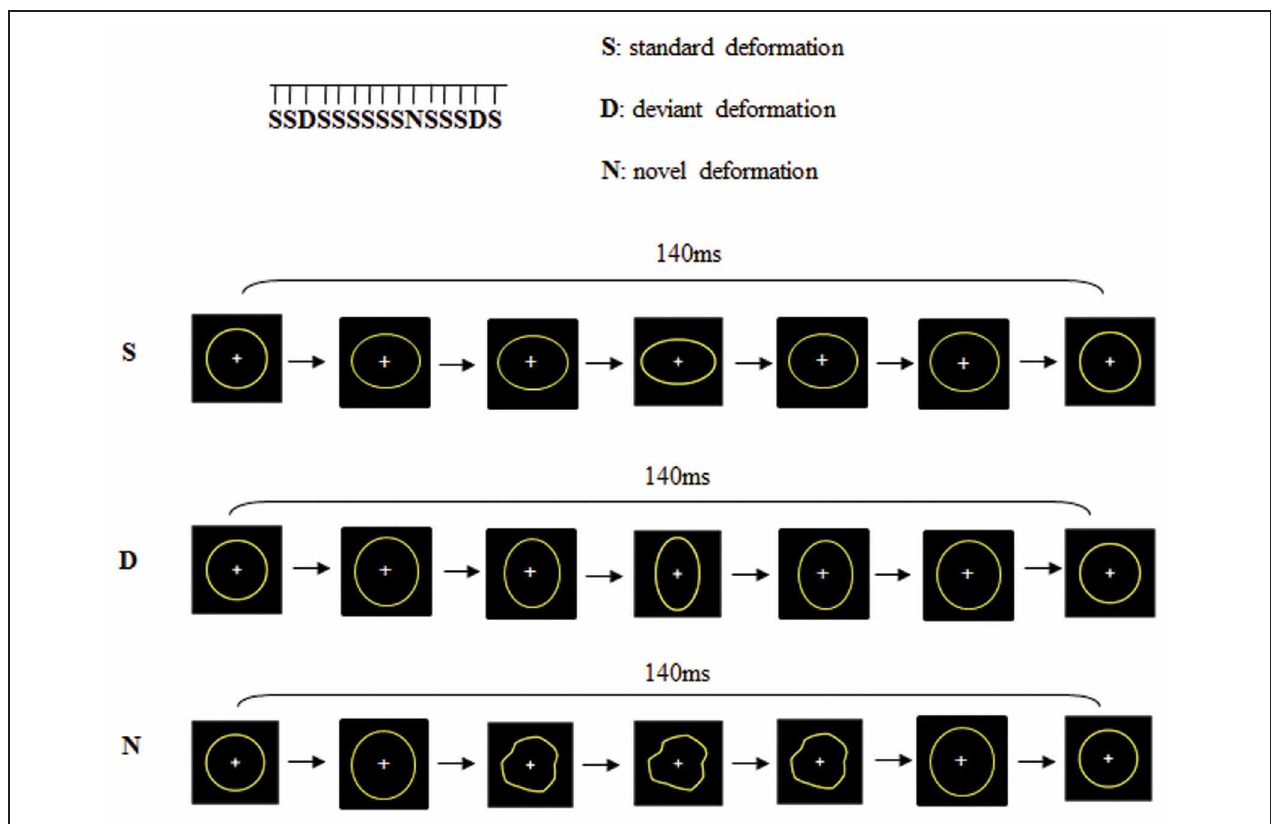
FIGURE 1 | Dynamic stimuli consisted on the deformation of a circle into an ellipse either horizontally (standard deformation) or vertically (deviant deformation) or into a new shape (novel deformation).